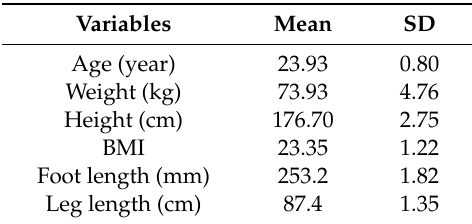
Table 1. Descriptive characteristics of